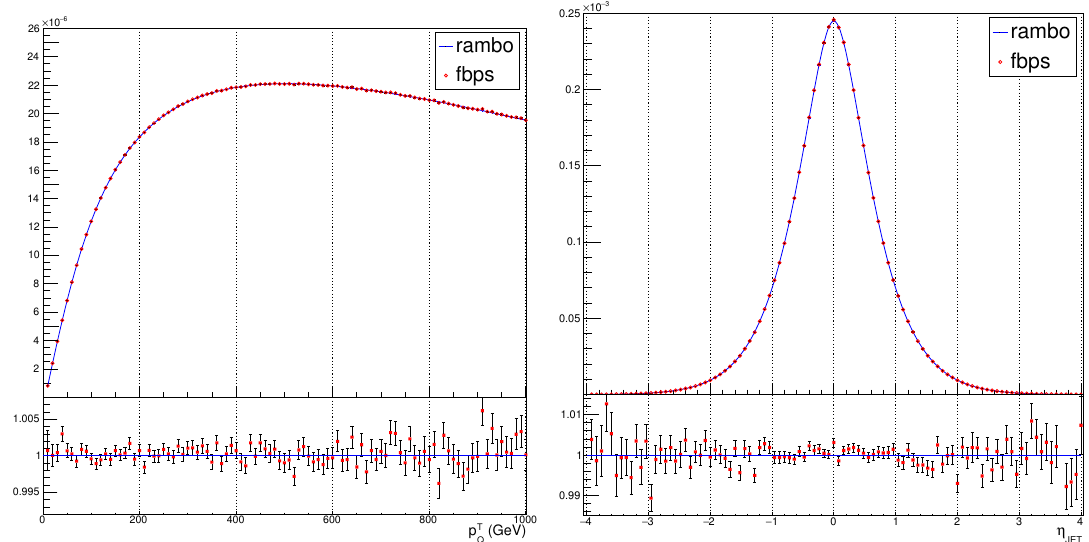
Figure 3 . A comparison between RAMBO and the FBPS generator of eq. (2.22). The left graph compares the vector boson p T , while the right graph compares the jet rapidity. For Rambo the V + 2 particle phase space was generated and a jet algorithm applied to obtain a V +1 jet exclusive (cid:12)nal state. For the FBPS generator the observables are the Born momenta, while the phase space weight is re-weighted by the bremsstrahlung